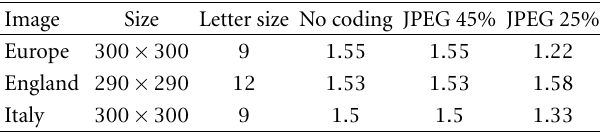
Table 3: Estimation of scale factor for three test images. For each image the initial size, the initial letter size, and the estimated scale factor under different coding conditions are given. The true scale factor is 1 . 5